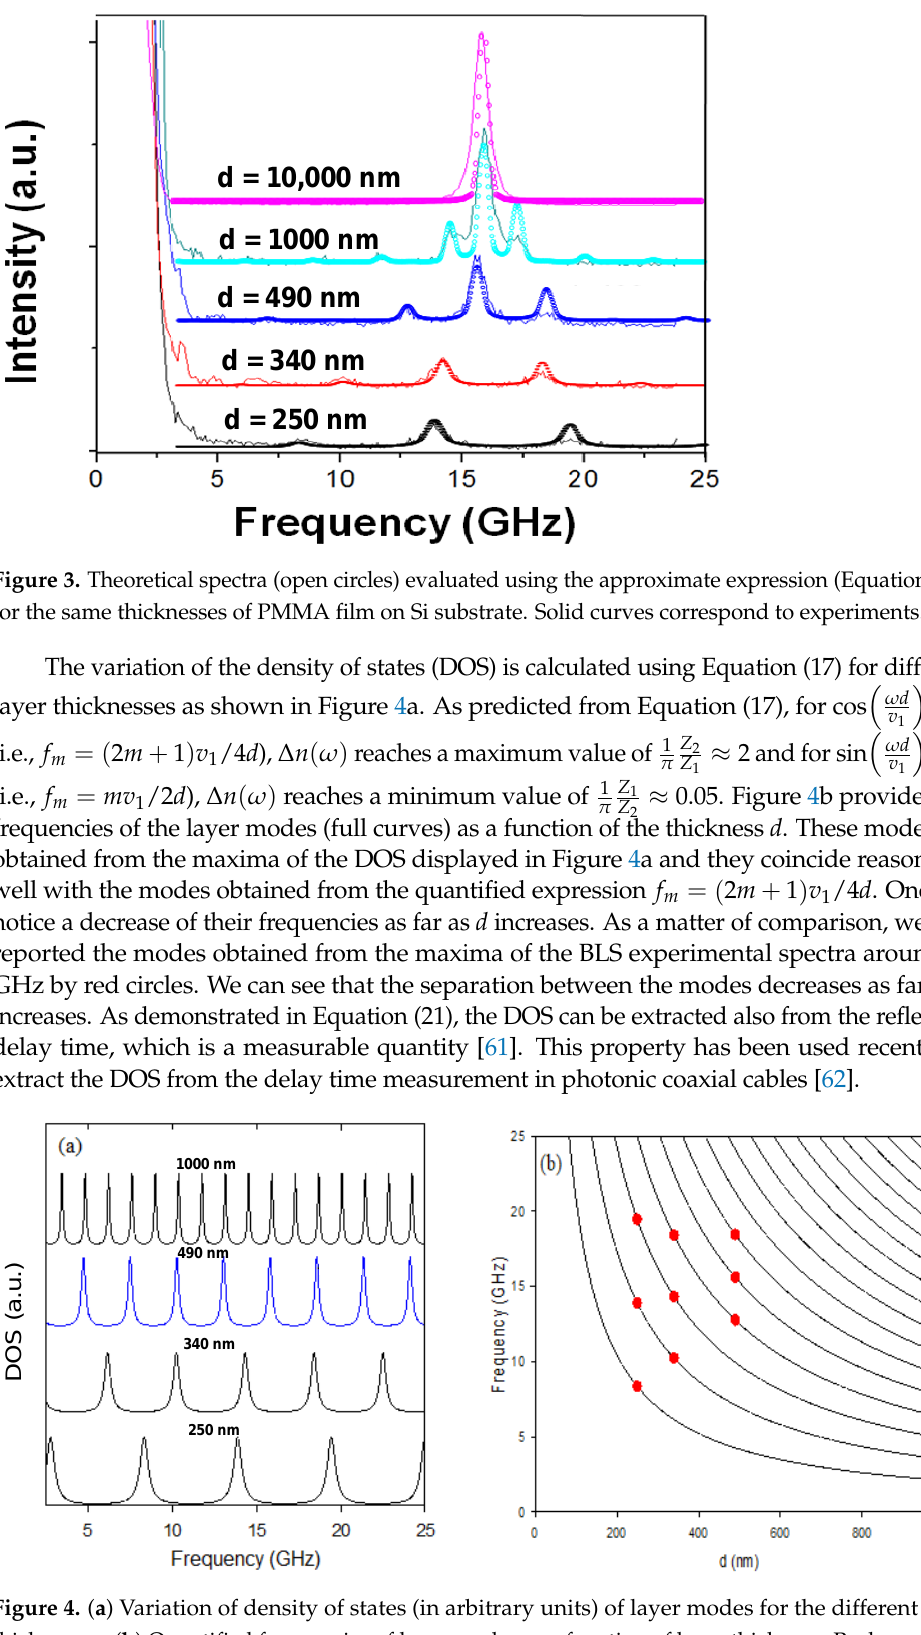
Figure 4. ( a ) Variation of density of states (in arbitrary units) of layer modes for the different layer thicknesses. ( b ) Quantified frequencies of layer modes as a function of layer thickness. Peak posi- tions of experimental spectra are given as red circles around the frequency 16 GHz. In order to give a comparison between BLS and DOS spectra, we have plotted in Figure 5 the DOS (blue curves) and the theoretical BLS spectra without convolution (red curves) for d = 490 nm. One can see clearly that among all the peaks in the DOS, only those